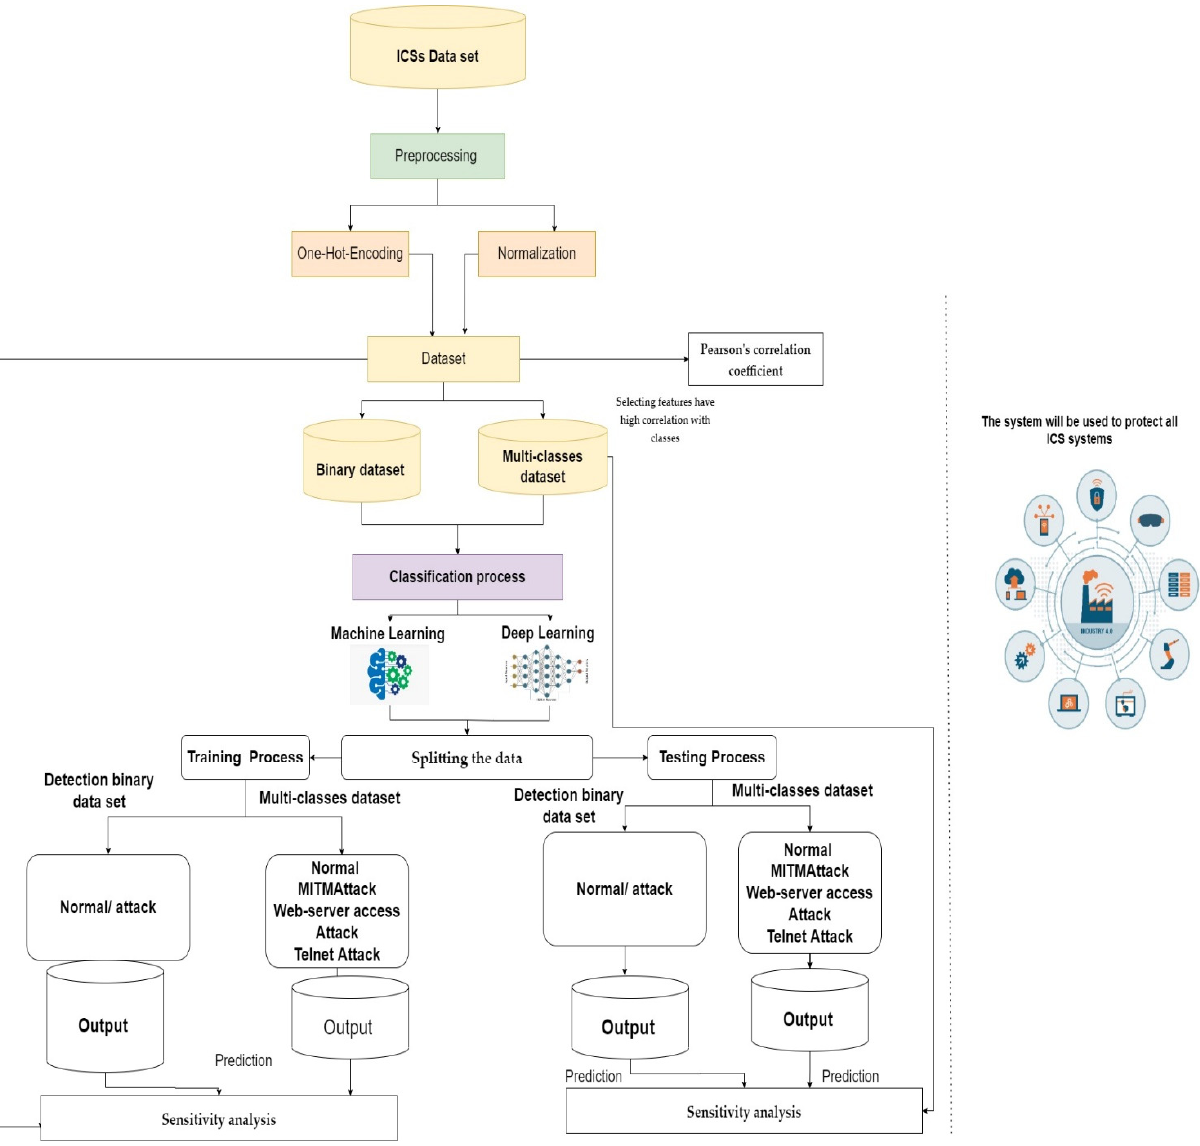
Figure 2. Framework of the ICS security system.